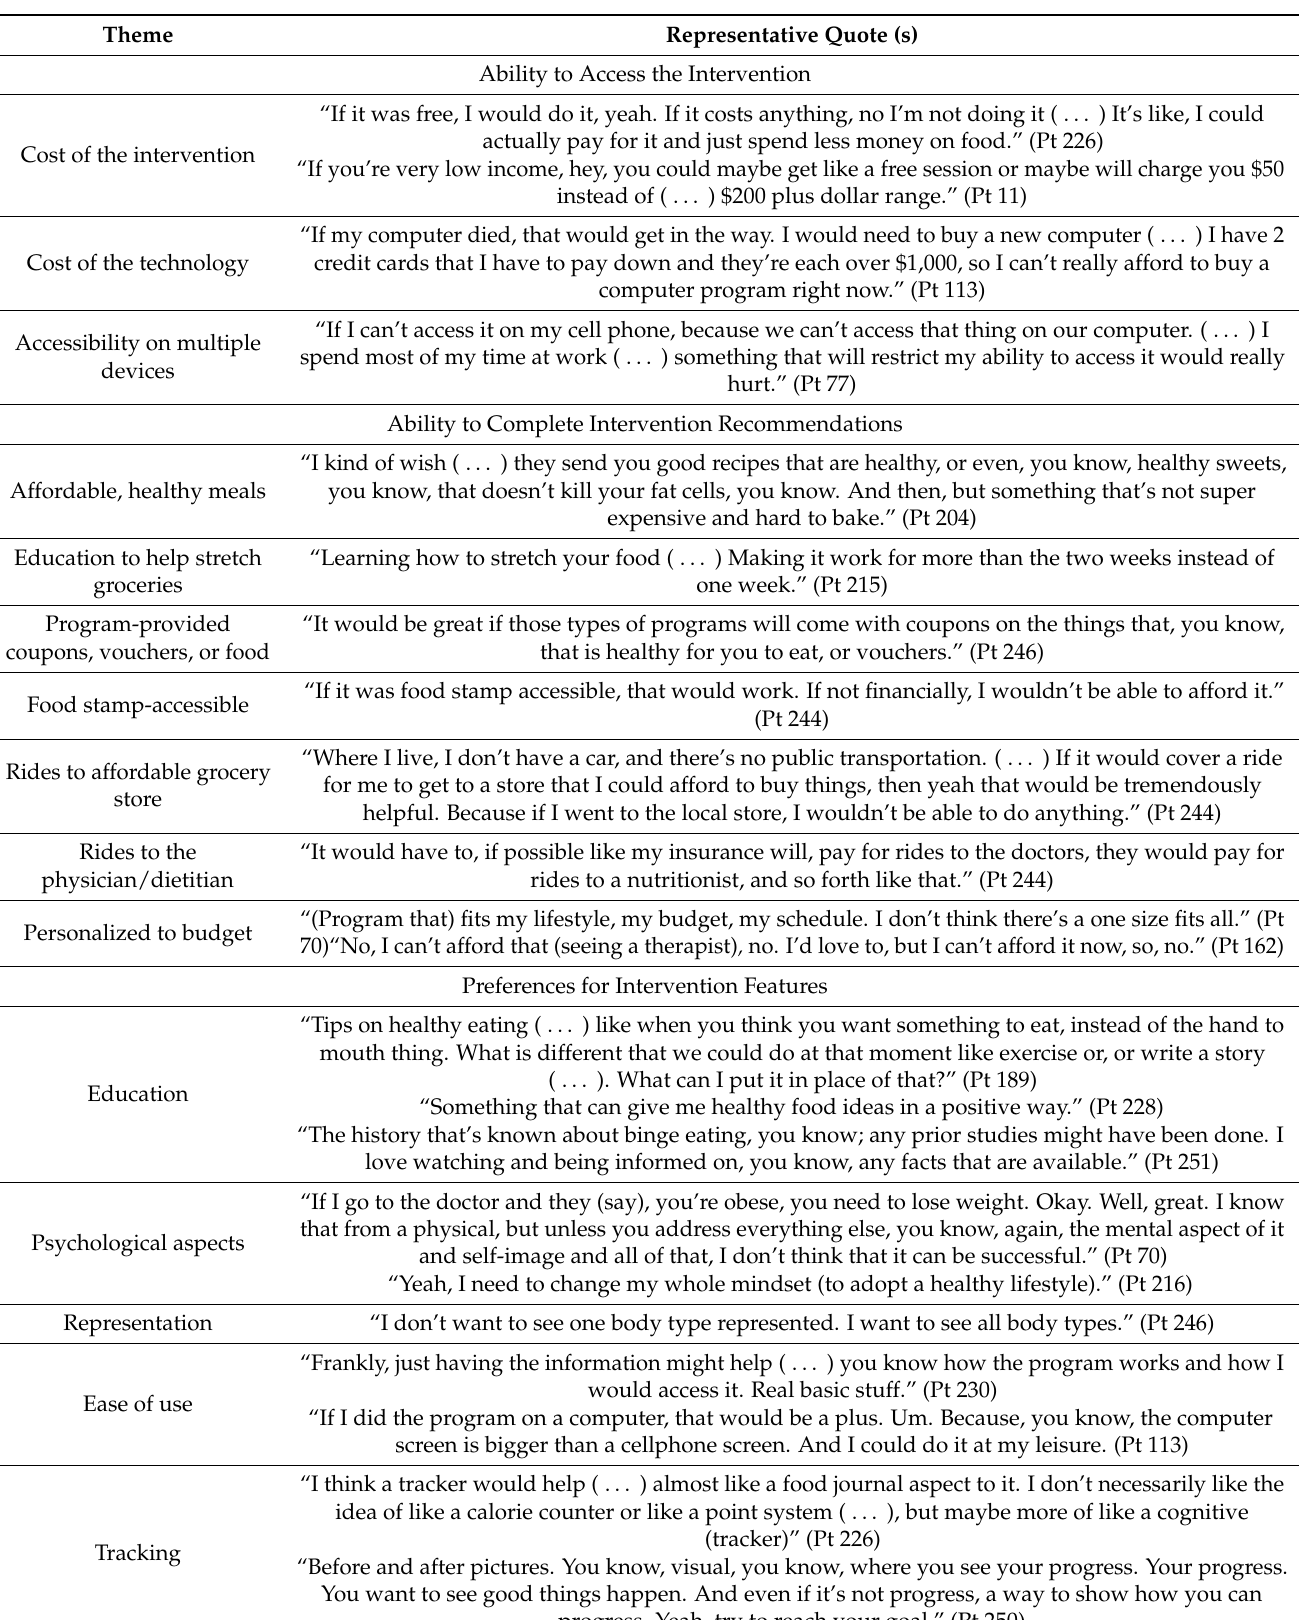
Table 1. Considerations for a digital intervention by people with food insecurity, binge eating, and